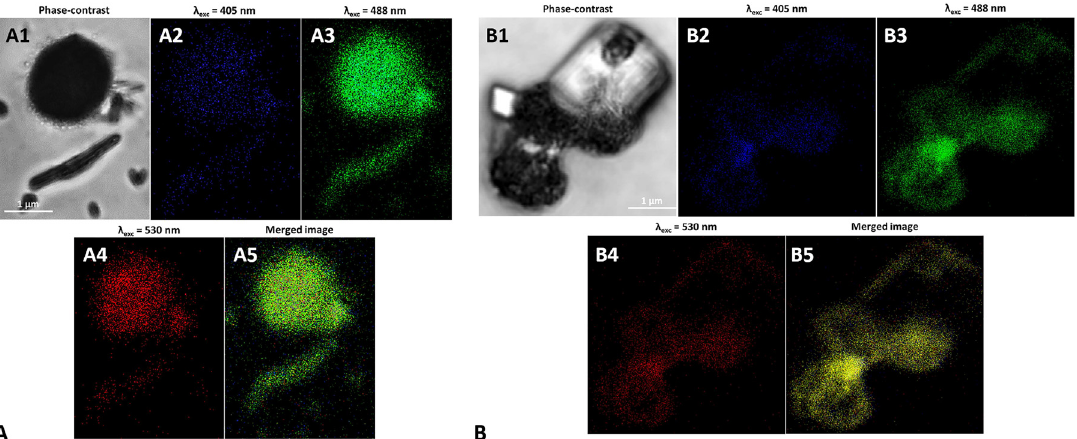
Figure 7: Super Resolution Confocal Microscopy images of (A) L -cys SeNPs_1:4 and (B) Bio SeNP extract_NB upon their excitation at (A2 and B2) 405, (A3 and B3) 488, and (A4 and B4) 530 nm. In (A1) and (B1) the phase contrast images of the samples are reported, while (A5) and (B5) show the photoluminescence merged